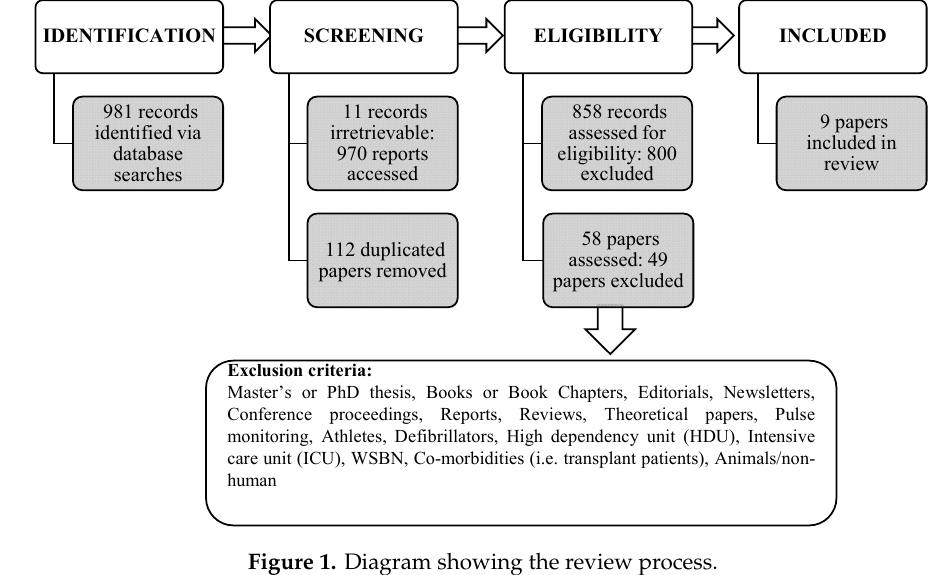
Figure 1. Diagram showing the review process .